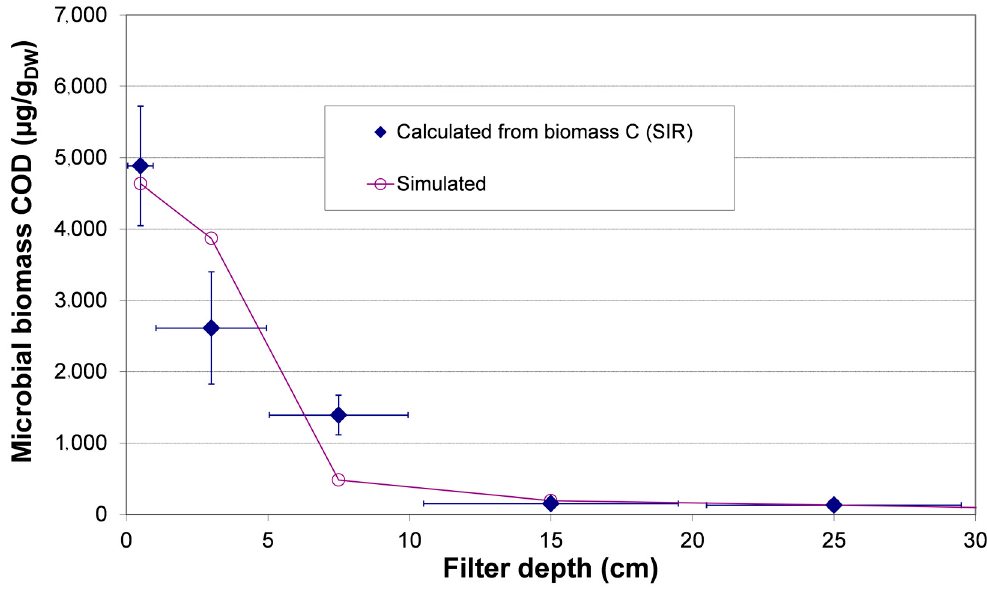
Figure 3. Calculated and simulated microbial biomass COD (Chemical Oxygen Demand) in different depths of the main layer of the VF pilot-scale wetland (adapted from [18,37]).